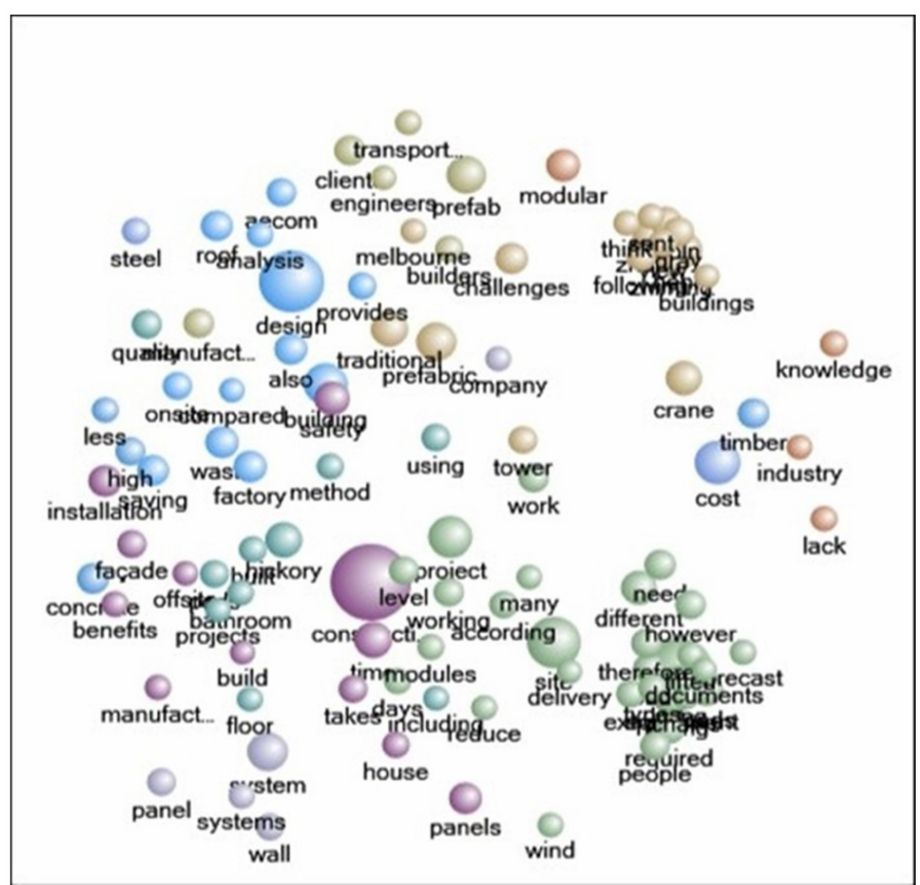
Figure 1. NVivo cluster analysis 3D